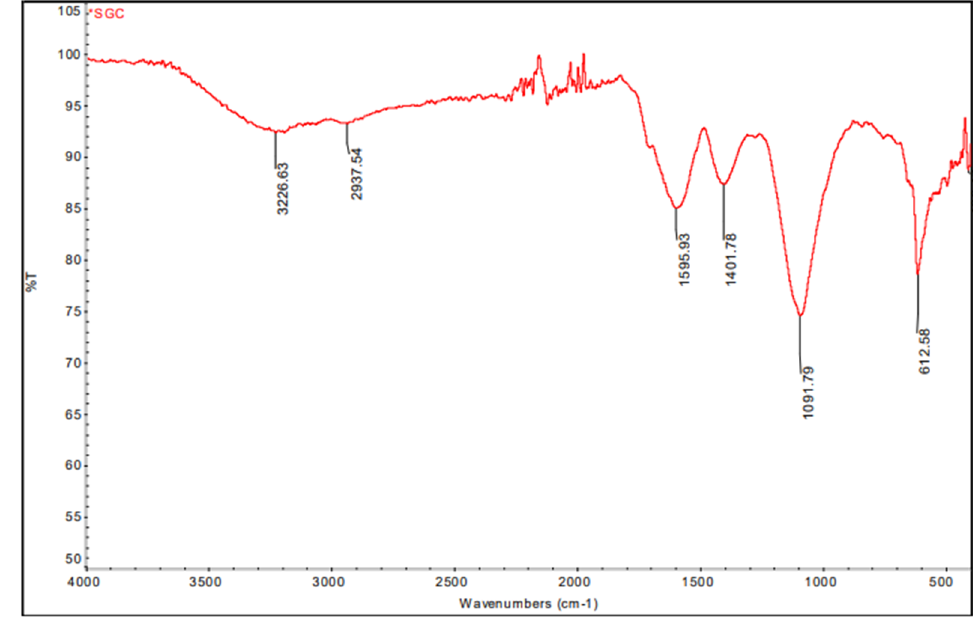
Figure 2. FTIR spectrum of Sg -CuO NPs.